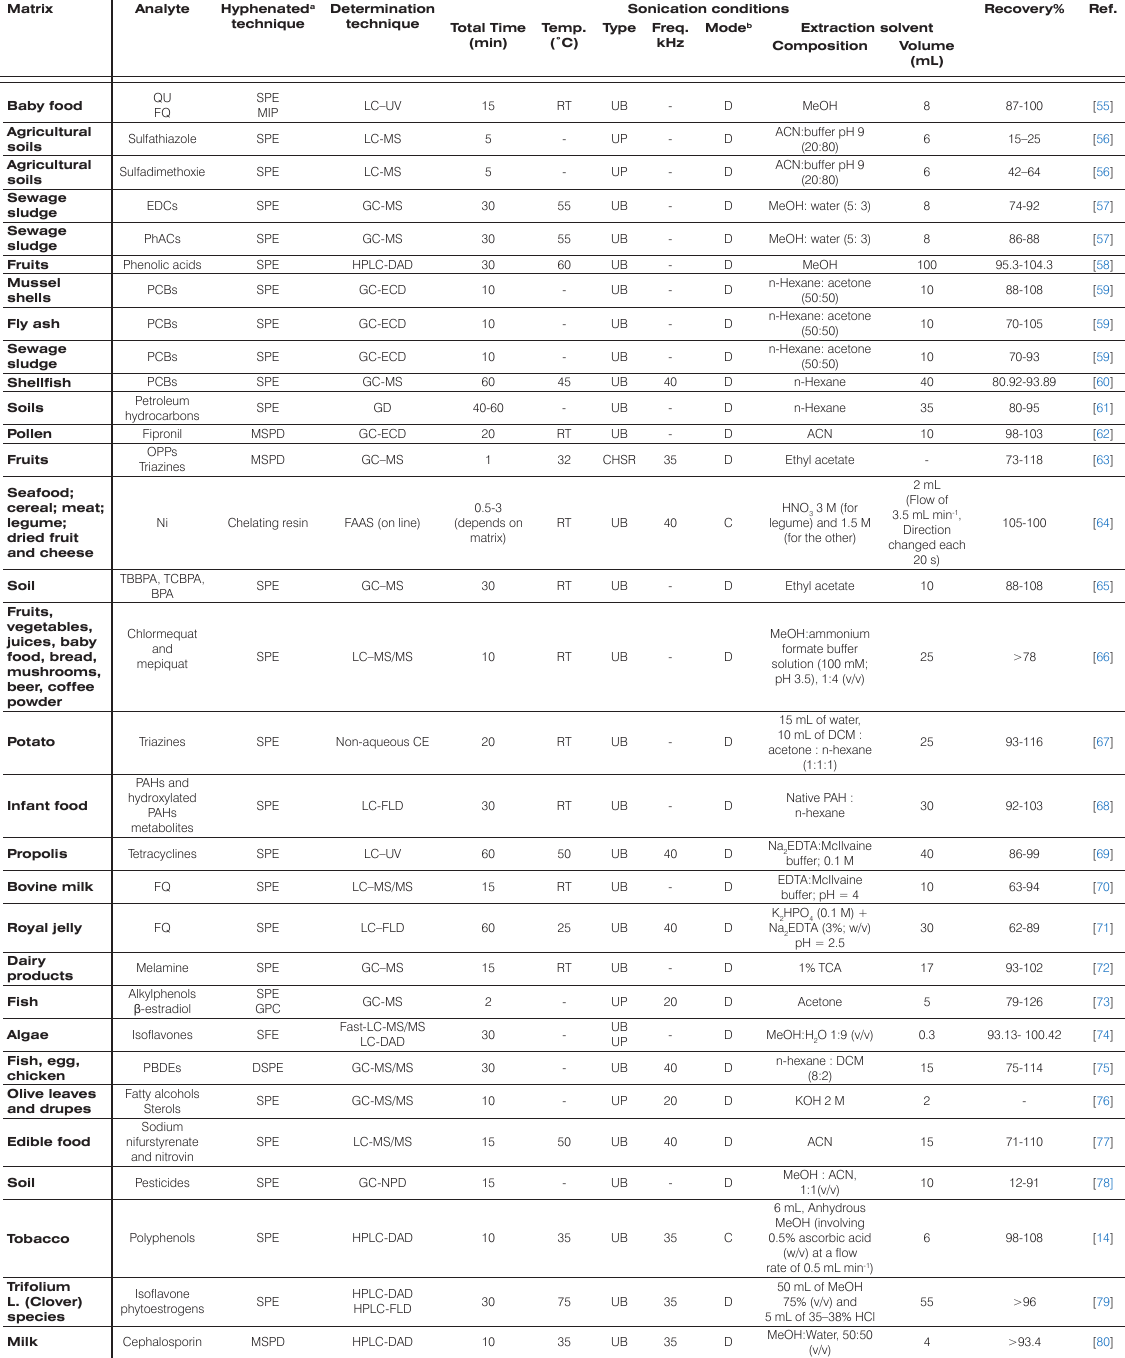
Table 2. Application of hyphenated techniques with ultrasound assisted extraction for determination of organic and inorganic compounds from different